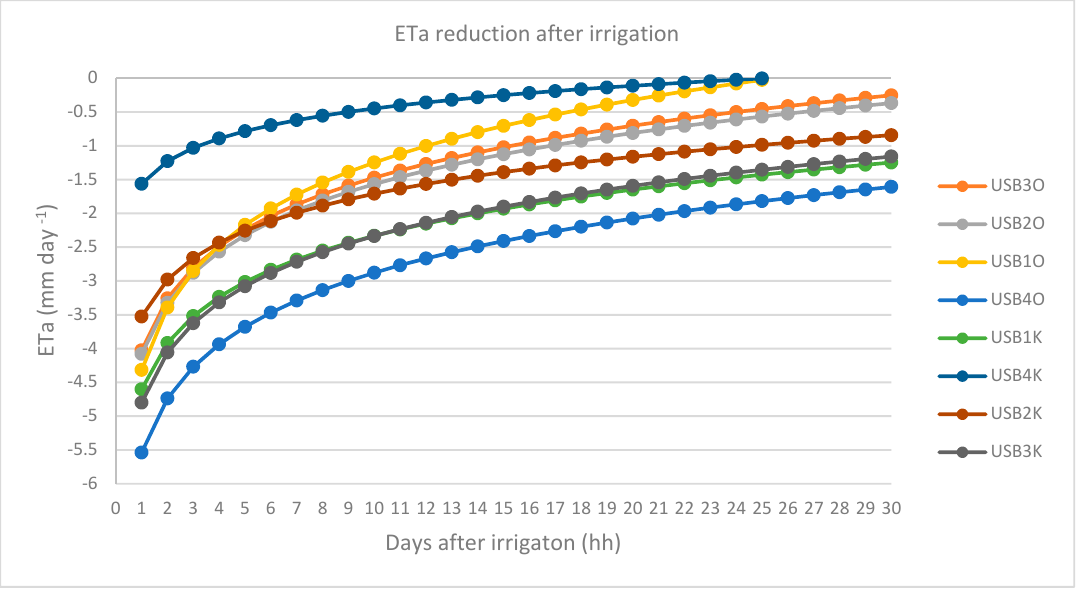
Figure 9. Logarithmic representation of the daily evaporation performance of irrigated green roofs over a period of 30 days.